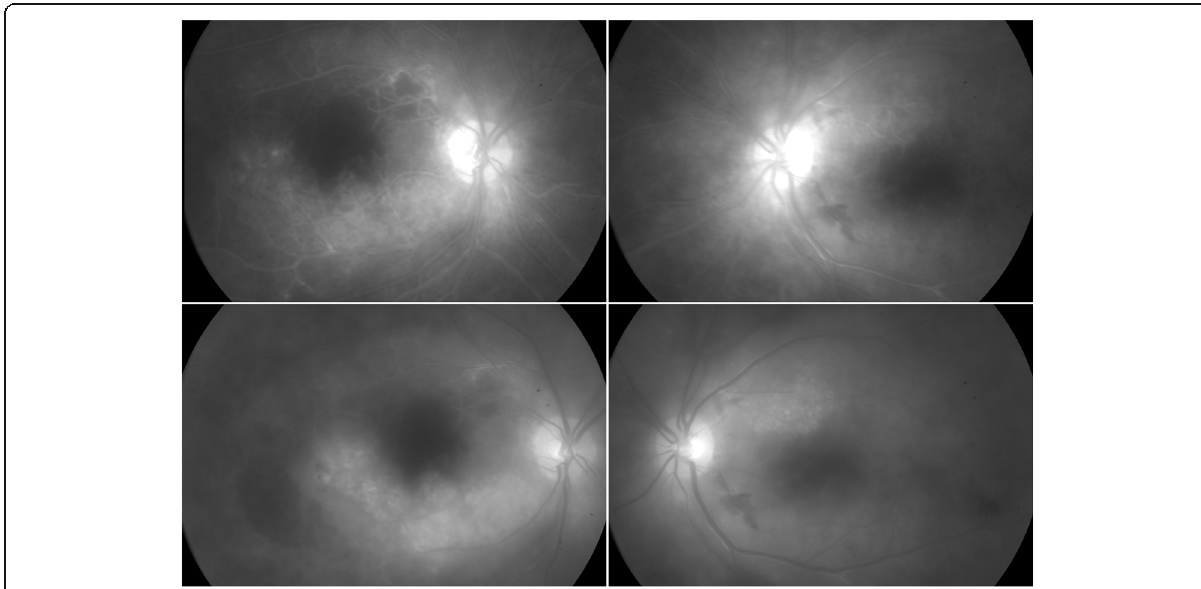
Fig. 2 Fluorescein angiography in early ( top row ) and mid/late phases ( bottom row ). Early phase shows vessel wall staining involving veins and collateral arteries. Mid/late phase shows corresponding leakage. The FAZ appears enlarged greater in the right compared to left eye